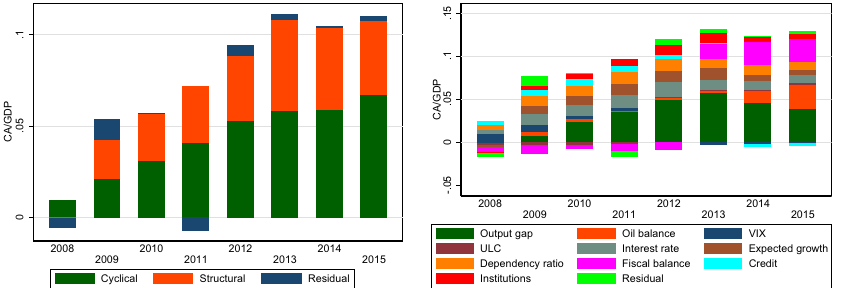
Fig. 5 Accumulated current account adjustment for Spain. Notes. The left panel plots the cyclical and structural components of the Spanish current account 2008–2015 adjustment together with the accumulated residual term identified from Eq. (3). The right panel plots the detailed decomposition with the contribution of each of the regressors included in the analysis (oil balance also includes oil